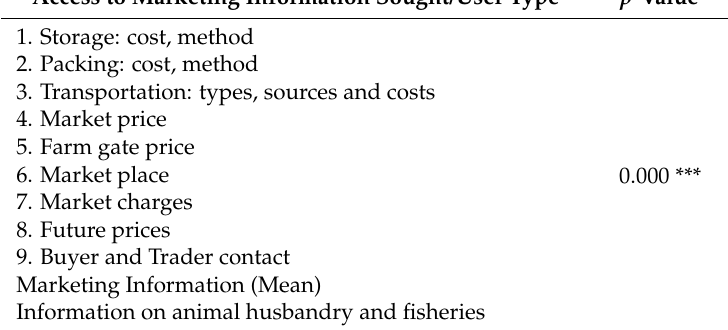
Table 6. Results of the One-way ANOVA regarding the influence of user type on access to different types of marketing information.